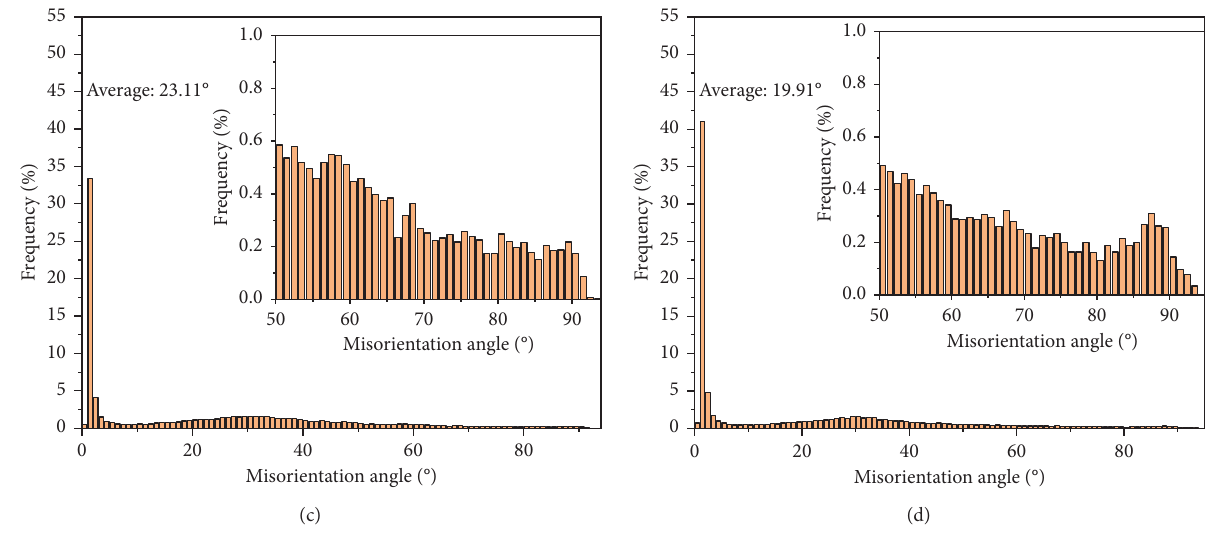
Figure 6: Misorientation angle distribution diagrams of the as-rolled Mg-6Sn-3Al-1Zn alloys at different rolling temperatures: (a) 300 ° C, (b) 350 ° C, (c) 400 ° C, and (d) 450 ° C.